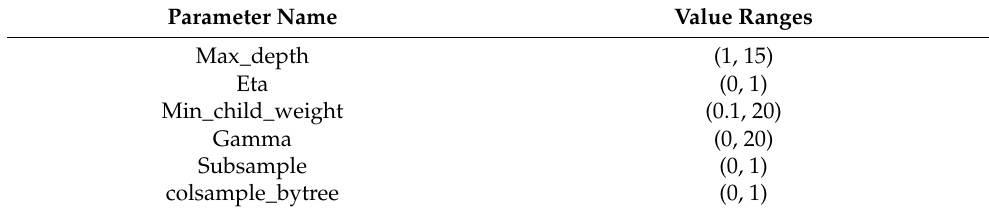
Table 6. Parameters and their value ranges.